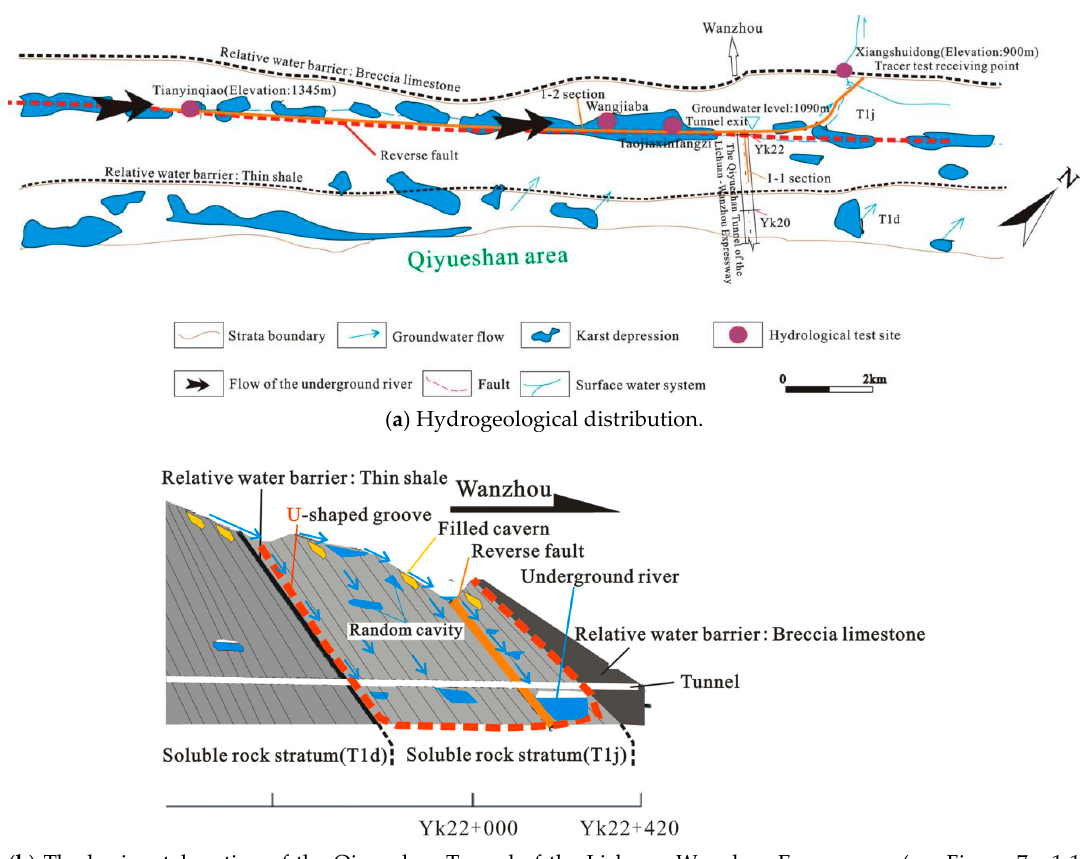
Figure 6. The underground river formation pattern controlled by the reverse fault. Image recreated from [24].